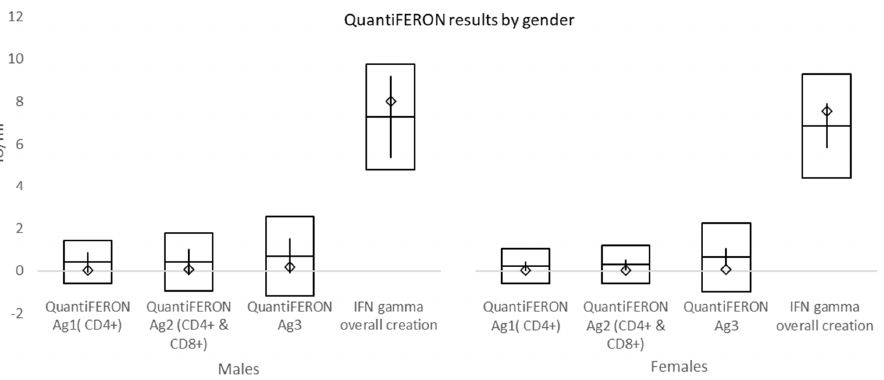
Figure 7. QuantiFERON results by gender. Mean values of QuantiFERON Ag1 activating CD4+ T cells, QuantiFERON Ag2 activating both CD4+ T cells and CD8+ Natural killer cells, and Quanti- FERON Ag3 activating CD4+, CD8+, and CD16+ (both T and B cells) were higher than cut-off (0.15– 0.20 IU/mL). Overall interferon- γ (IFN- γ ) >10 IU/mL was shown in 63.8% of subjects. There was no signi fi cant di ff erence between males and females for any of these tests. □ mean ± standard deviation; ◊ median; │ minimum − maximum. Table 7. Two-sided p -values for difference in laboratory tests between body mass index (BMI) groups. * The significant difference. ** The two-tailed significance probability that could not be measured, therefore p -value for equal variance is assumed.